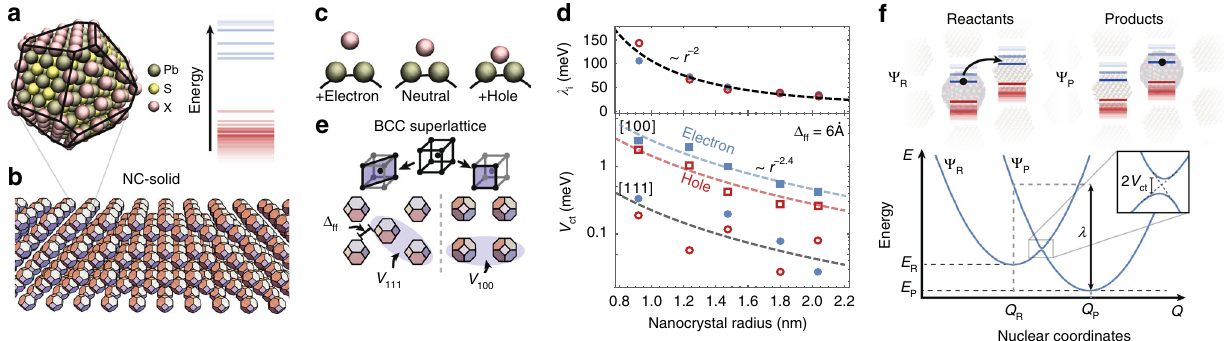
Fig. 1 Charge transfer in NC solids. a Atomistic model of a PbS nanocrystal (NC) with halide (I) surface passivation and its quantized electronic structure. b Depiction of a thin fi lm of nanocrystals (i.e, an NC solid). c Schematic of the nuclear reorganization, where the Pb – X bonds on the surface of the NC expand or shrink in the presence of an electron or hole. d Calculated reorganization energy (top) and electronic coupling (bottom) for electrons (blue) or holes (red) between [100] (squares) and [111] (circles) nearest neighbors (as depicted in e ), assuming a facet-to-facet distance, Δ ff , of 6 Å in the [111] direction. f Con fi gurational diagram for charge transfer between two nanocrystals, where an electron (black dot) moves from the nanocrystal on the left (con fi guration of reactants, Q R , with ground state energy E R ) to the nanocrystal on the right ( Q P and energy E R ). The reorganization energy ( λ ) and electronic coupling ( V ct ) is